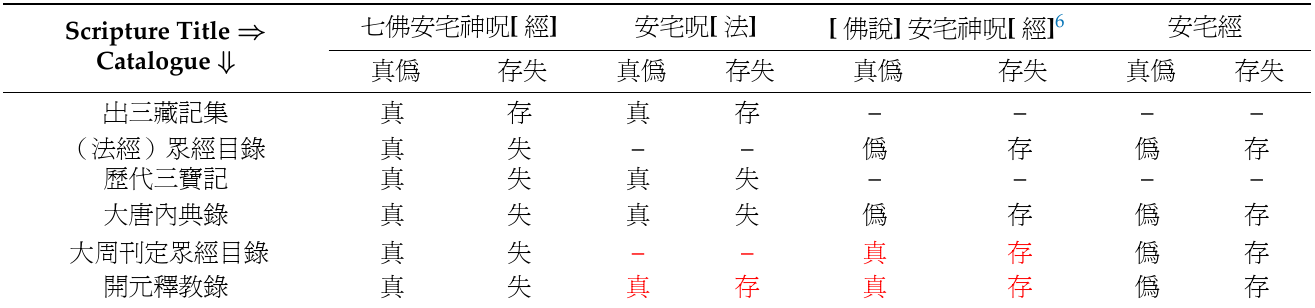
Table 1. Overview of the six catalogues compiled between the Liáng 梁 dynasty and the Táng 唐 dynasty with respect to the ānzhái 安宅 scriptures and the judgment whether they are “authentic” ( zhēn 真 ) or “fake/not authentic/apocryphal” ( wěi 偽 ), “extant” ( c ´ un 存 ), or “lost” ( shī 失 ). Note the critical change in the classification of the Ānzhái shénzhòu jīng from 偽 to 真 in the Dà ‑ Zhōu kāndìng zhòngjīng mùlù and its subsequent